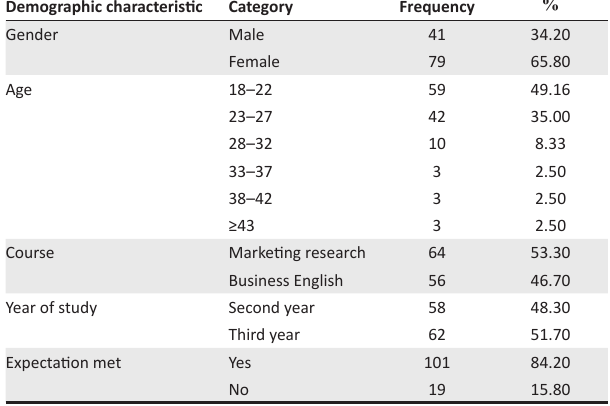
TABLE 1: Demographic characteristics of respondents ( n =